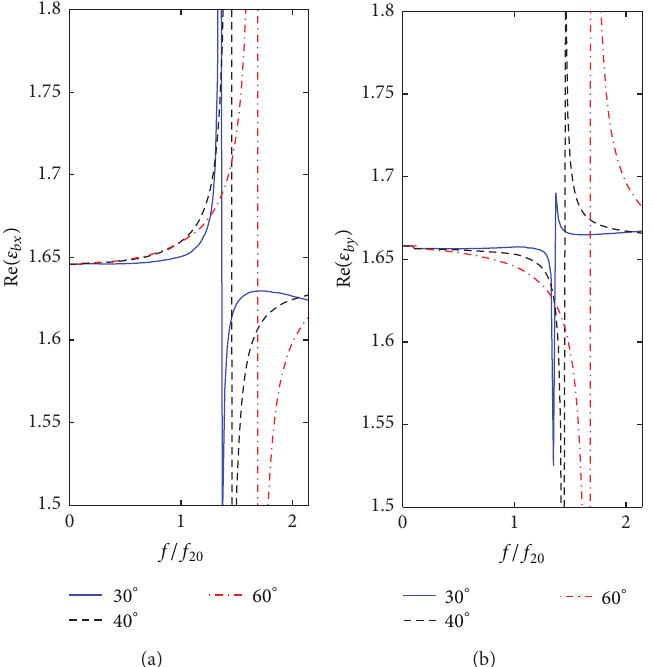
Figure 12: Retrieved 𝜀 𝑏𝑥 and 𝜀 𝑏𝑦 for various 𝜃 0 by (13)–(16) under the condition that 𝜀 𝑚 is angle independent and equals 𝜀 𝑚 (𝜃 0 = 0) of the IBL model.